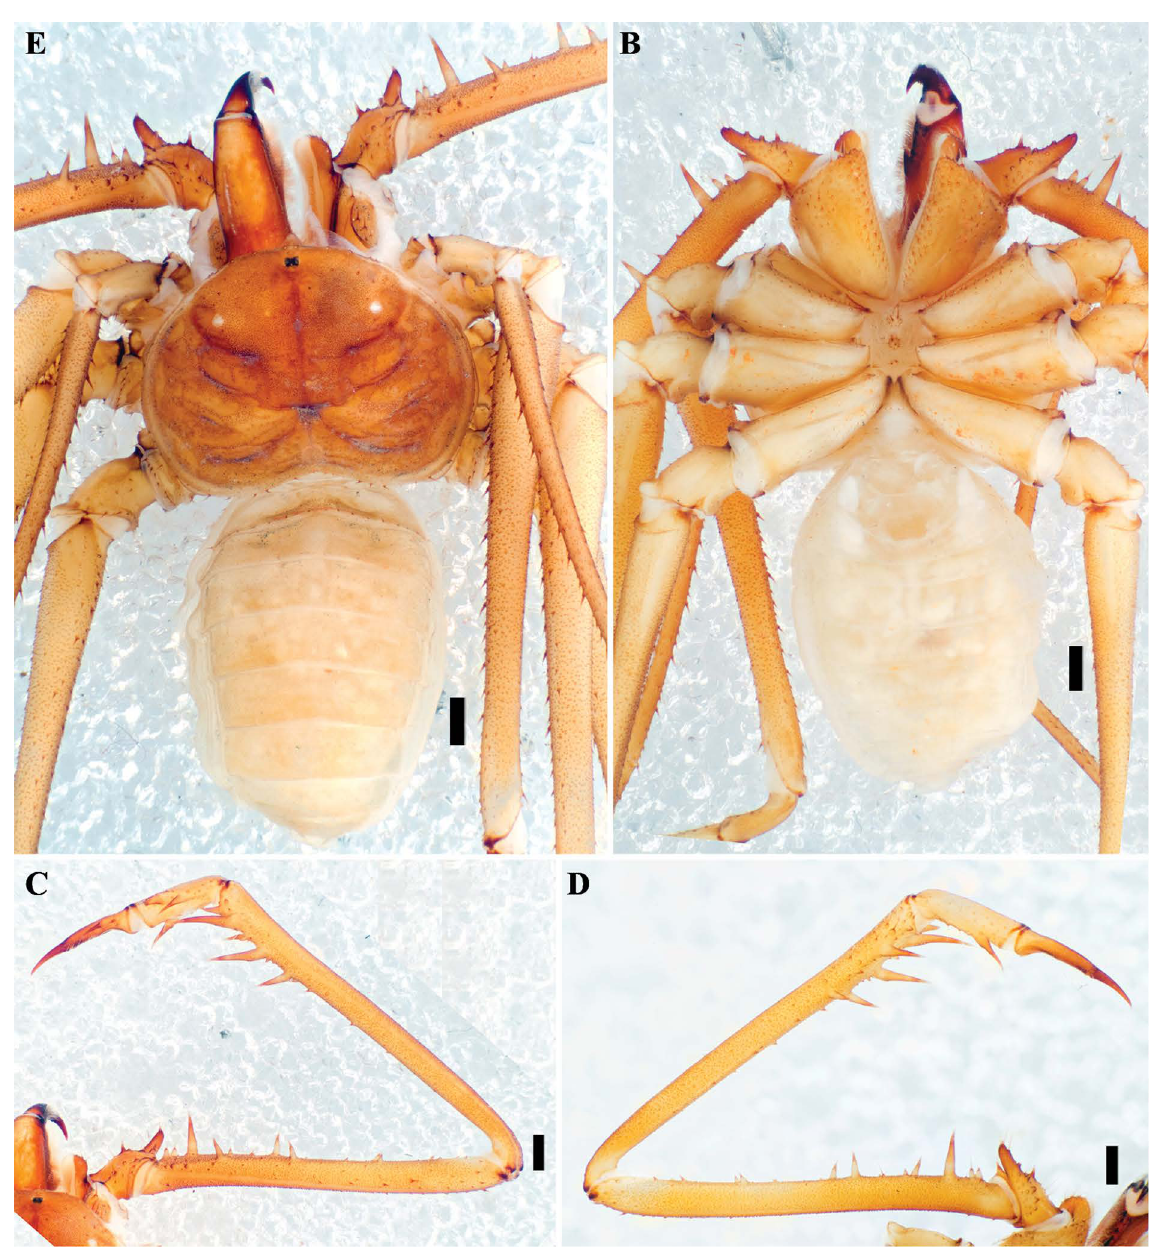
Fig. 93. Charinus milloti Fage, 1939 (MNHN), general morphology, ♂. A . Habitus, dorsal view. B . Habitus, ventral view. C . Pedipalp, dorsal view. D . Pedipalp, ventral view. Scale bars: